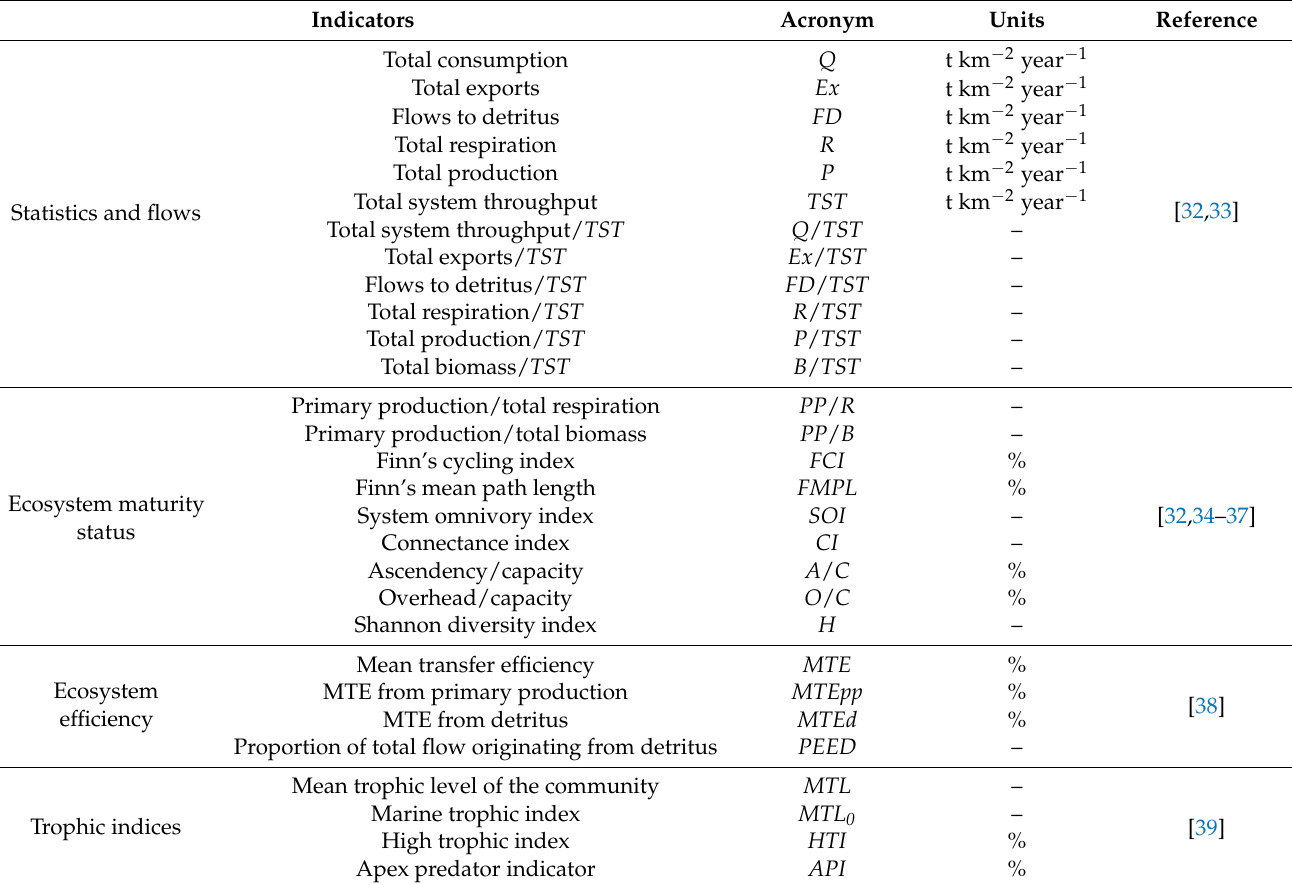
Table 1. Indicators of trophic network